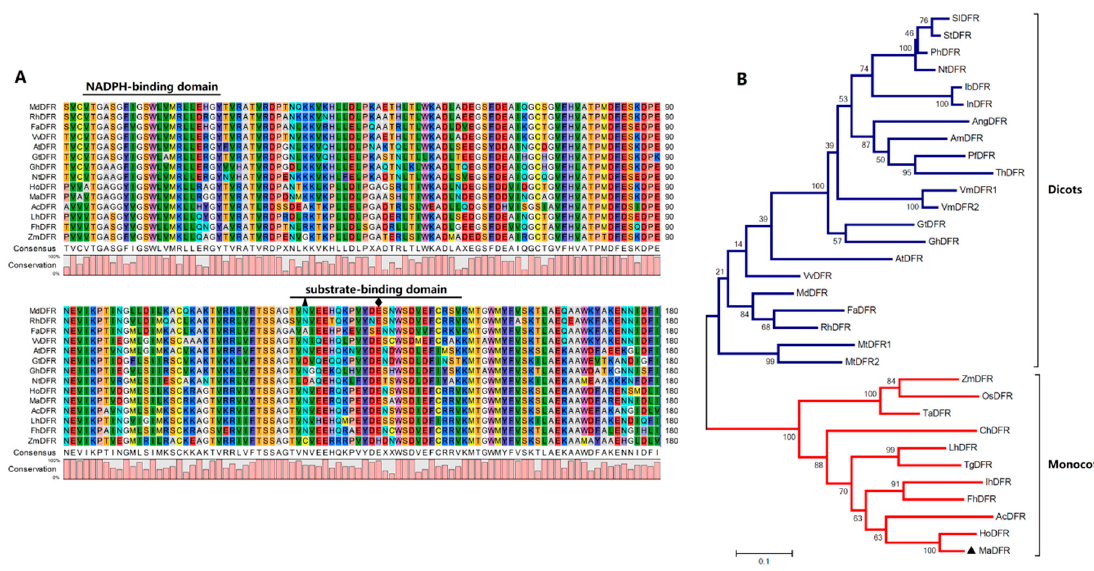
Figure 1. Alignment of the protein sequence and phylogenetic tree analysis of MaDFR. ( A ). Multiple sequence alignment of the predicted amino acid sequences of MaDFR and dihydroflavonol 4-reductase (DFR) proteins from other plant species. The alignment was generated using CLC Sequence Viewer 8.0. The NADPH-binding and substrate-binding domains of DFR are indicated. Substrate specificity of DFRs is particularly associated with amino acids at positions 134 and 145, indicated by the black triangle and black rhombus, respectively. DFR conserved amino acid residues are highlighted in di ff erent colors. ( B ). Phylogenetic analysis of MaDFR with other DFR proteins. The phylogenetic tree was generated using the maximum likelihood method in MEGA 7.0 software. Numbers at each interior branch indicate the bootstrap values of 1000 replicates. The bar indicates a genetic distance of 0.1. Plant species and GenBank accession numbers of their DFR proteins used for phylogenetic analysis are: Muscari aucheri MaDFR (MH636605, marked with a black triangle), Solanum lycopersicum SlDFR (CAA79154.1), Solanum tuberosum StDFR (AF449422), Petunia × hybrida PhDFR (AF233639), Nicotiana tabacum NtDFR (NP_001312559.1), Ipomoea batatas IbDFR (HQ441167), Ipomoea nil InDFR (AB006793), Angelonia angustifolia AngDFR (KJ817183), Antirrhinum majus AmDFR (X15536),